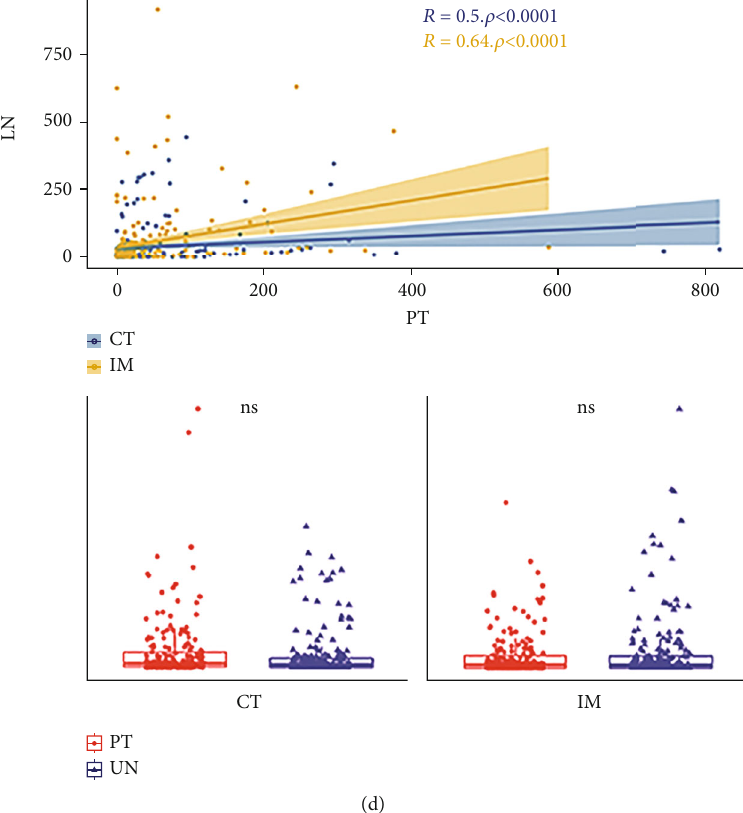
Figure 2: The in situ immune patterns of T cells and cytotoxic T cells were di ff erent in primary tumors (PTs) and metastatic lymph nodes (mLNs). (a, d) The densities of T lymphocytes (CD3+) and cytotoxic T cells (CD8+) were signi fi cantly correlated between PTs and mLNs at the center of tumor (CT) and invasive margin (IM) regions. (a) The densities of stromal T lymphocytes (S-CD3+) were signi fi cantly higher in mLNs than in PTs at both the CT and IM regions. (b, d) In tumor compartment, the densities of T cells (T-CD3+) and cytotoxic T cells (T-CD8+) were not signi fi cantly di ff erent. (c) The densities of stromal cytotoxic T cells (S-CD8+) were signi fi cantly higher in mLNs than in PTs at IM region. S =stroma; T =tumor; ns =not signi fi cant; ∗∗∗∗ P < 0 : 0001